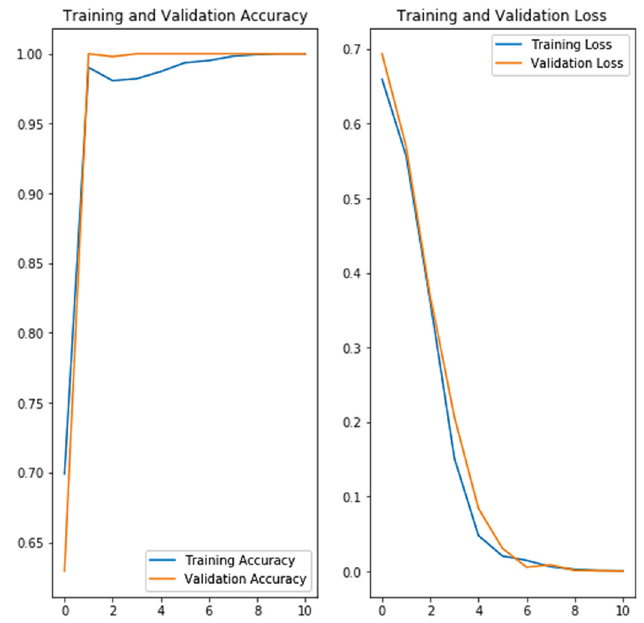
Figure 6 . The model accuracy . Figure 6. The model accuracy.